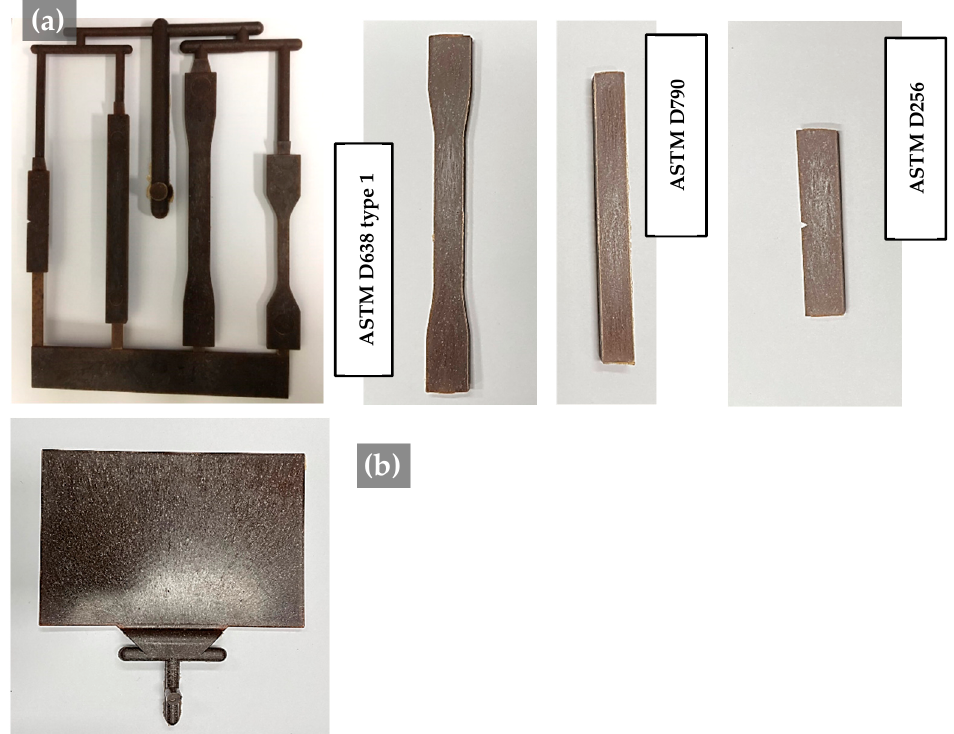
Figure 2. Injection-molded PP/SOC, biocomposite containing polypropylene (PP) and SOC: ( a ) specimen for mechanical properties evaluation; ( b ) specimen for SEM, XRD. Table 4. Composition of PP/SOC specimens.